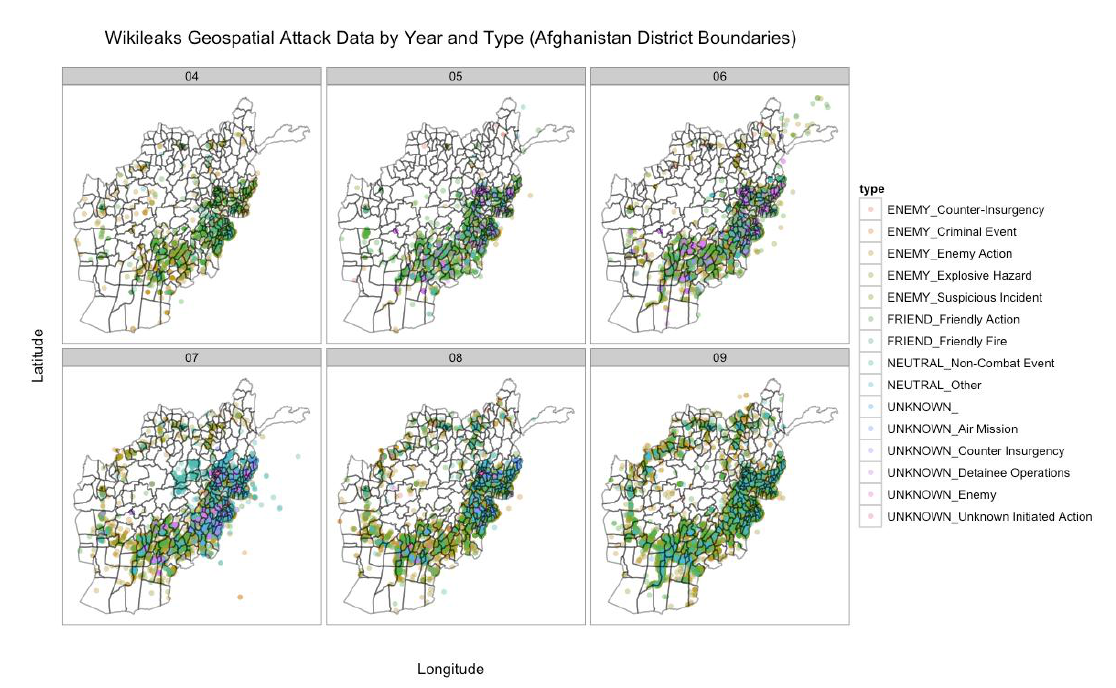
Fig. 3: Visualisation of the progress of the Afghan War, 2004-9, by Drew Conway (2010) Such efforts also mirror similar forms of user-driven, crowdsourced processing of large public datasets elsewhere – notably, for example, The Guardian ’s harnessing of its readership in sifting through the expenses records of UK Members of Parliament, which it had obtained under Freedom of Information legislation, as part of its investigation into the parliamentary expenses